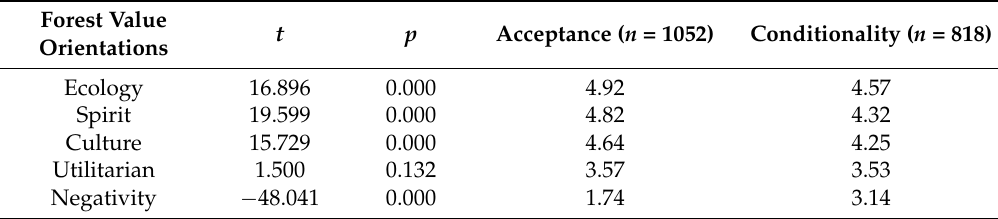
Table 2. Cluster analysis result and overall mean scores.